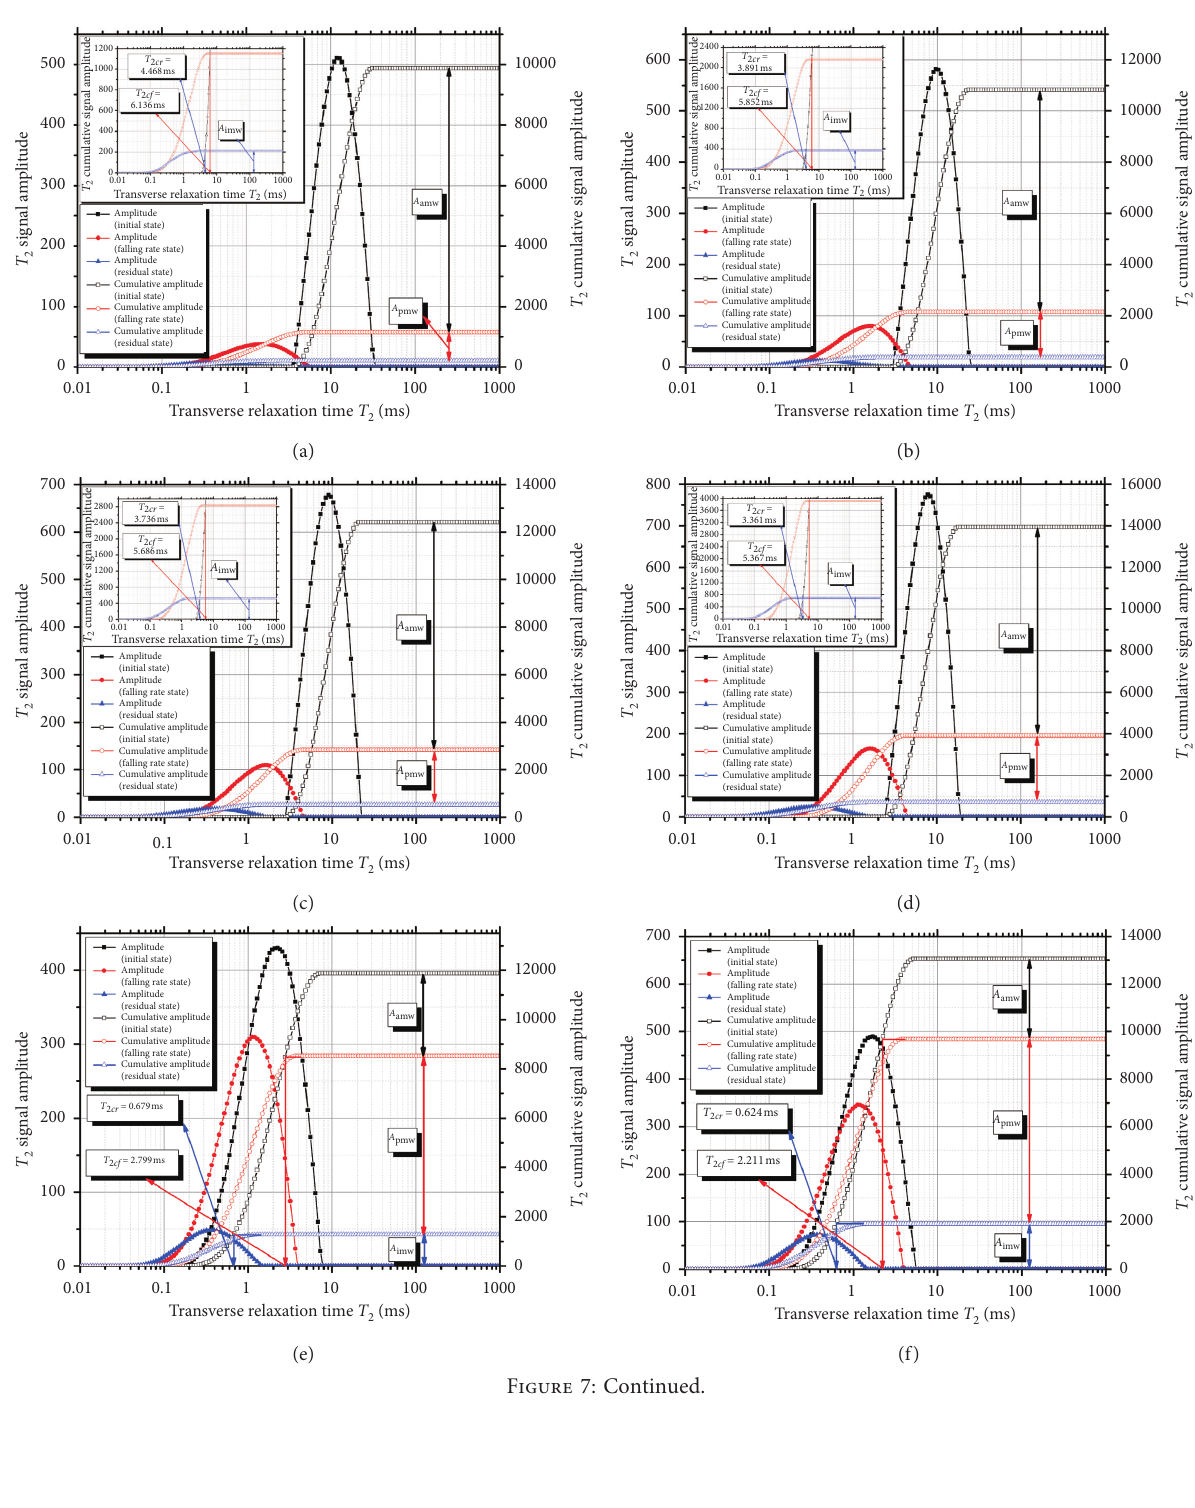
Transverse relaxation time T 2 (ms) Amplitude (initial state) Amplitude (falling rate state) Amplitude (residual state) Cumulative amplitude (initial state) Cumulative amplitude (falling rate state) Cumulative amplitude (residual